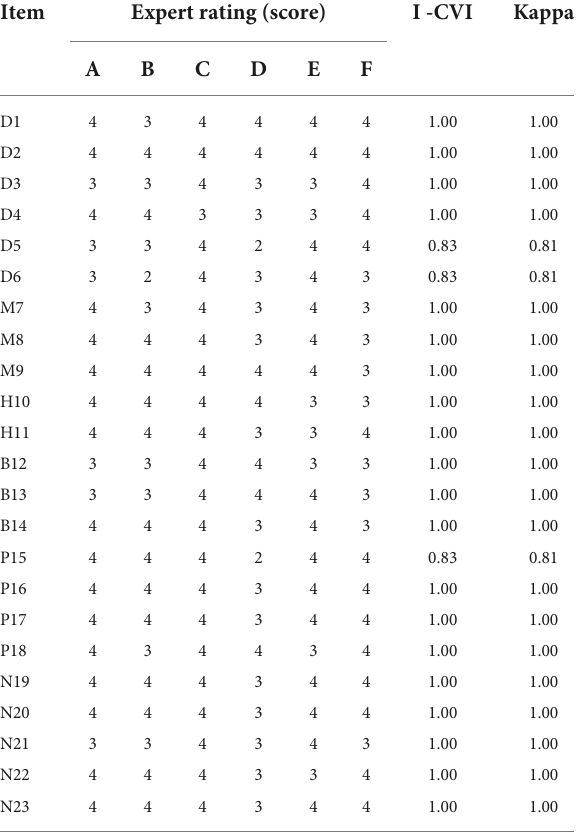
TABLE 3 Content validity analysis of each item for the Chinese version of SDSC-I ( n = 432).